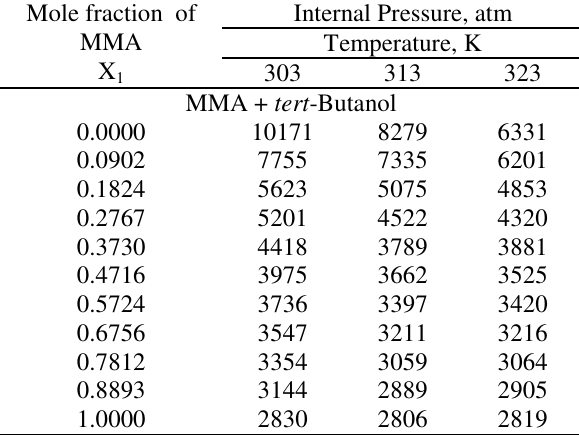
Table 2. Internal pressure of MMA +